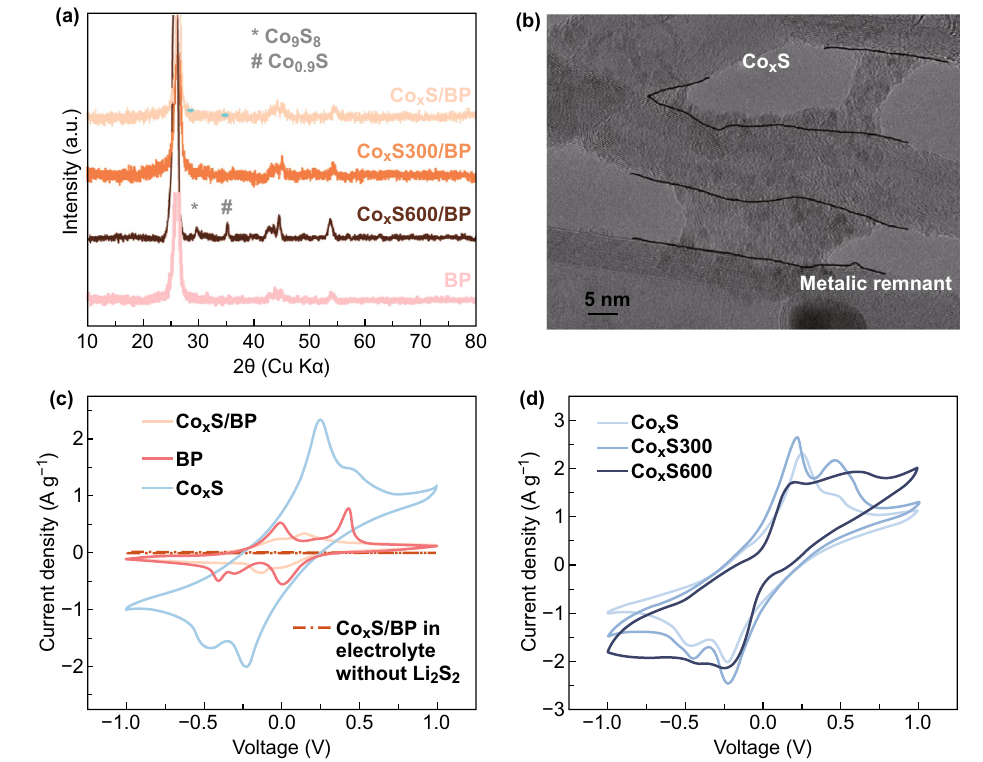
Fig. 3 a XRD patterns of Co x S/BP, BP, Co x S300/BP, and Co x S600/BP. b TEM image of Co x S/BP. c CV of Co x S/BP electrode in symmetric cell containing electrolytes with/without 0.1 M Li 2 S 6 at 3 mV s −1 in comparison with its constituents. d CV of symmetric cells using Co x S electrodes annealed by different